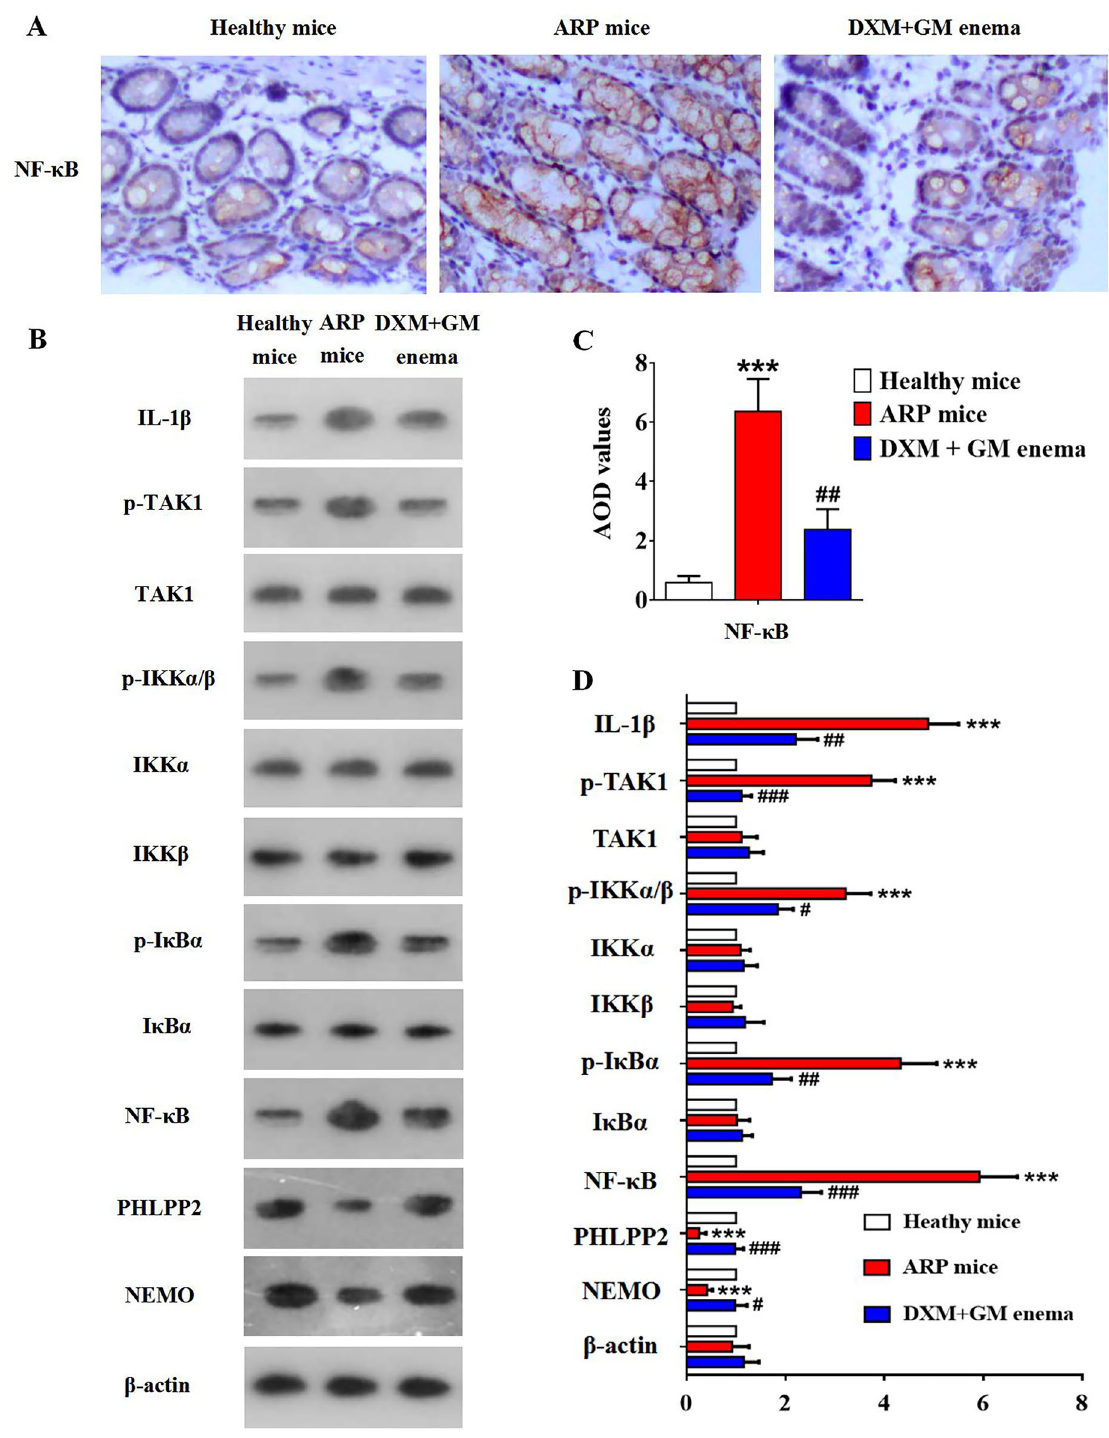
Figure 6. DXM + GM enema ameliorates inflammation by inhibiting NF-κB signaling pathway in ARP mice. ( A ) The immunohistochemistry of NF-κB in different groups of mice (n = 10 for each group) was observed under light microscopy (scale ×400). ( B ) The expression of NF-κB signaling pathway was tested by using western blot. ( C ) AOD values of NF-κB were detected by immunohistochemistry in different groups of mice (*** P < 0.001, ## P < 0.01). ( D ) The expression of IL-1β, p-TAK1, p-IKKα/β, p-IκBα and NF-κB in rectal tissue of ARP mice was higher than that in healthy control group; however, the expression of PHLPP2 and NEMO was lower than that in healthy control group (*** P < 0.001). DXM + GM enema inhibited the expression of IL-1β, p-TAK1, p-IKKα/β, p-IκBα and NF-κB, while up-regulated the expression of PHLPP2 and NEMO ( # P < 0.05, ## P < 0.01, ### P <